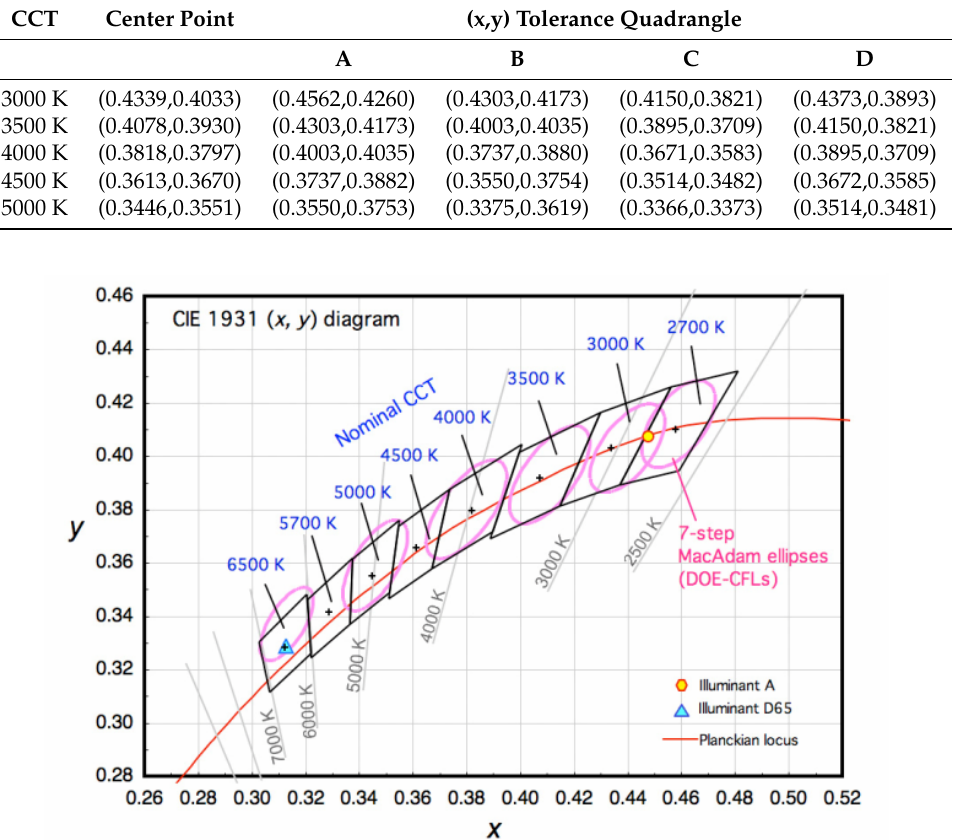
Figure 4. The chromaticity tolerance with the quadrangle range for LED products on the CIE 1931 chromaticity Figure A1, Part 1 Graphical representation of the chromaticity specification of SSL products in Table 1, on the CIE (x,y ) chromaticity diagram